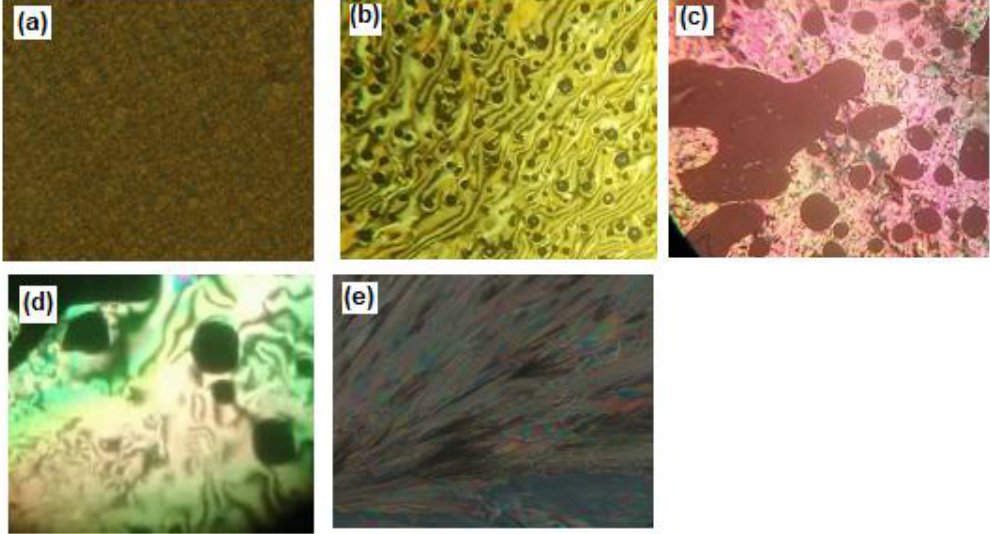
Figure 3. POM texture of I/A8 ( a ) solid phase at 40.0 °C ; ( b ) Schlieren N phase at 110.0 °C upon heating; ( c ) Schlieren N phase at 116.0 °C upon heating; ( d ) Schlieren N phase at 114.0 °C upon cooling; ( e ) solid phase at 20.0 °C.